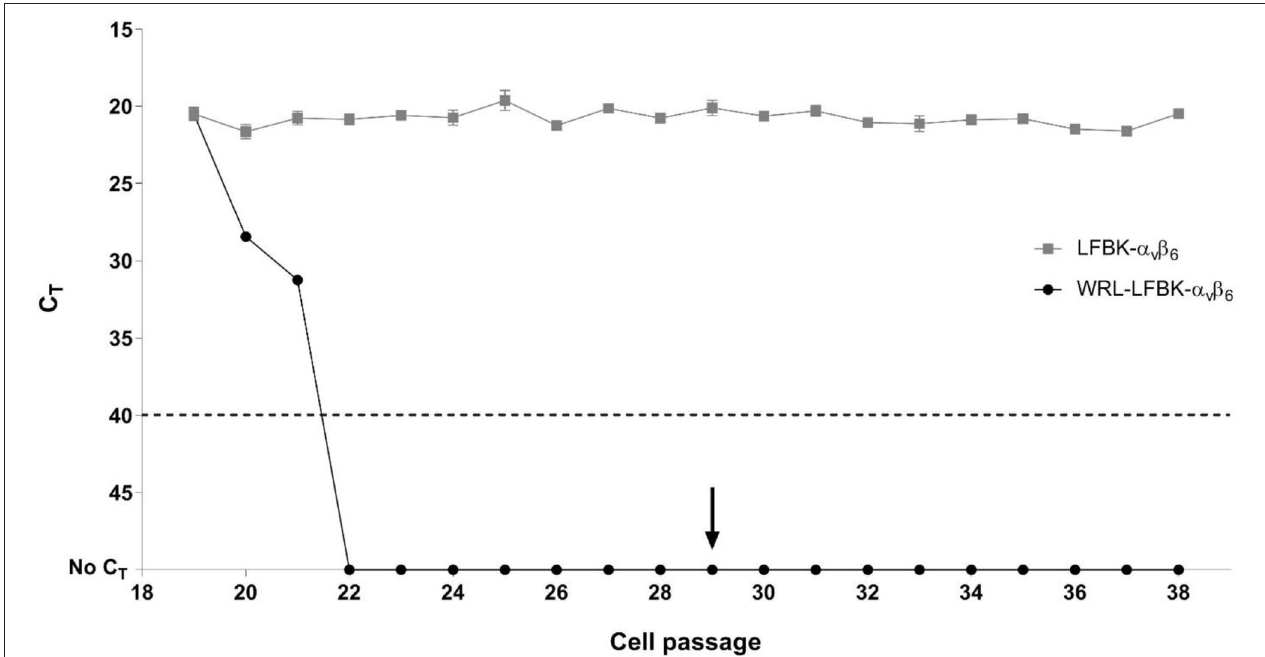
FIGURE 1 | Elimination of BVDV from LFBK- α v β 6 cells as detected by real-time RT-PCR. BVDV was undetected in unclarified cell suspensions of WRL-LFBK- α v β 6 cells after three passages with 4 µ M DB772 treatment. Data points represent the average C T ( n = 3) ± standard deviation. The dotted line denotes the pestivirus assay cut-off (C T of < 40), and the arrow indicates the first passage at which DB772 treatment was stopped for the WRL-LFBK- α v β 6 cells.